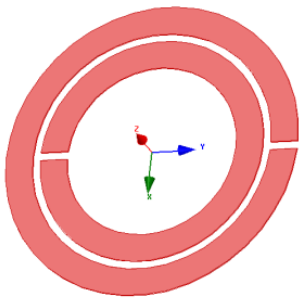
Figure 12. Circular SRR designed in HFSS.